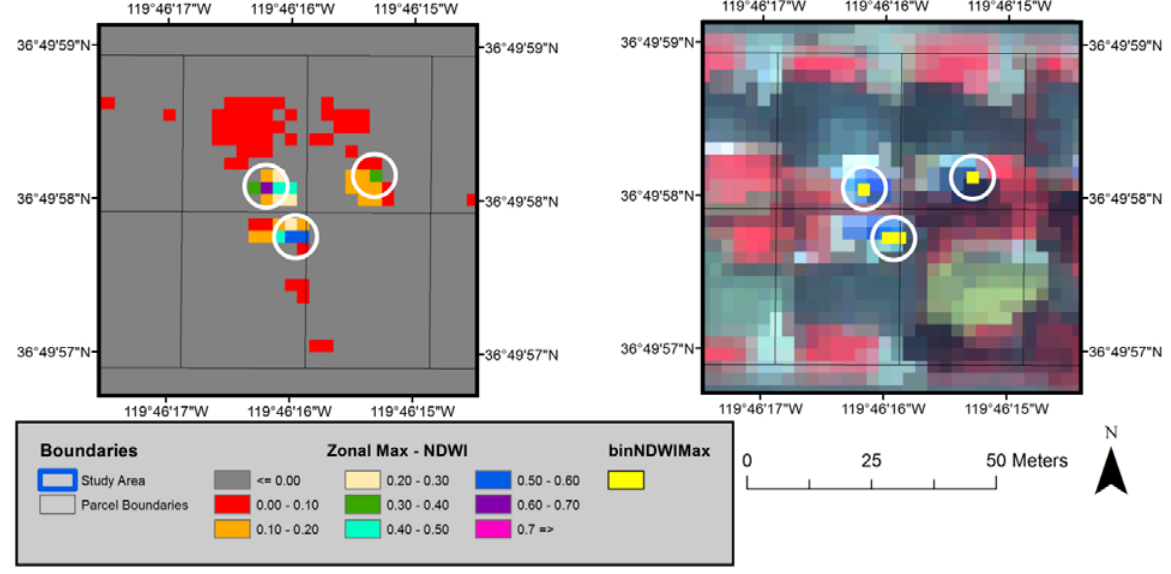
Figure 6. Color-coded NDWI image of four residential parcels ( left ). QuickBird image (copyright 2013) showing the near infrared (NIR), red, and green false color composite, and the location of the pixels composed of the maximum NDWI values of the file binNDWIMax which are represented as yellow squares ( right ). The white circles show the locations in both